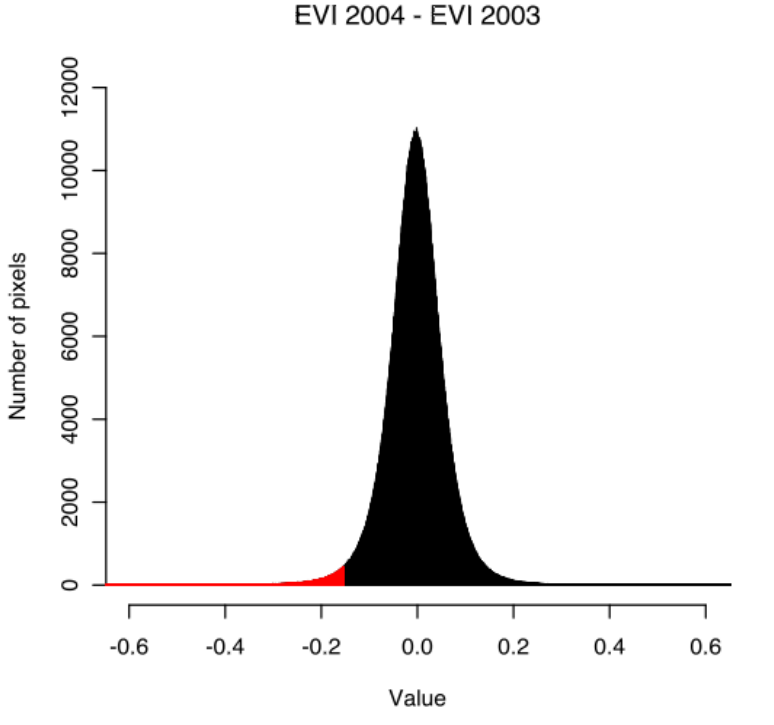
Figure 5. Histogram of the differentiated EVI images of 2004 and 2003 with pixels representing hotspots highlighted in red according to a −0.1570 detection